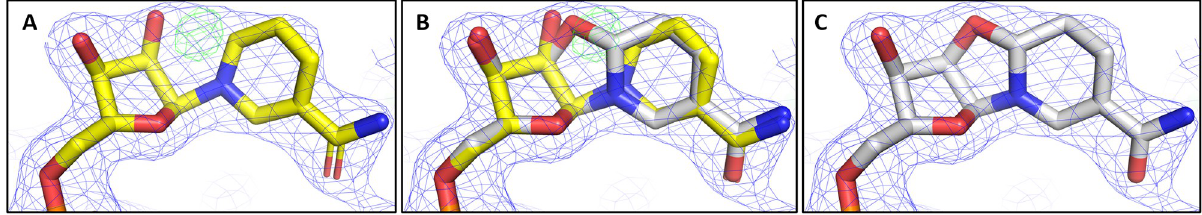
Fig 3. NADPH anomers in the electron densities. a. Refinement of α -NADPH (yellow) in the SaDHFR:R-27 crystal structure. Green mesh (difference density) shows unsatisfied electron density. b. Overlay of α -NADPH and t-NADPH (light gray) in the SaDHFR:R-27 crystal structure. c. Refinement of t-NADPH in the SaDHFR:R-27 crystal